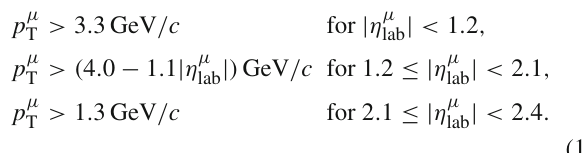
function onto the respective axes are overlaid as solid lines . The long- dashed lines show the fitted contribution of nonprompt J /ψ mesons. The fitted background contributions are shown by short-dashed